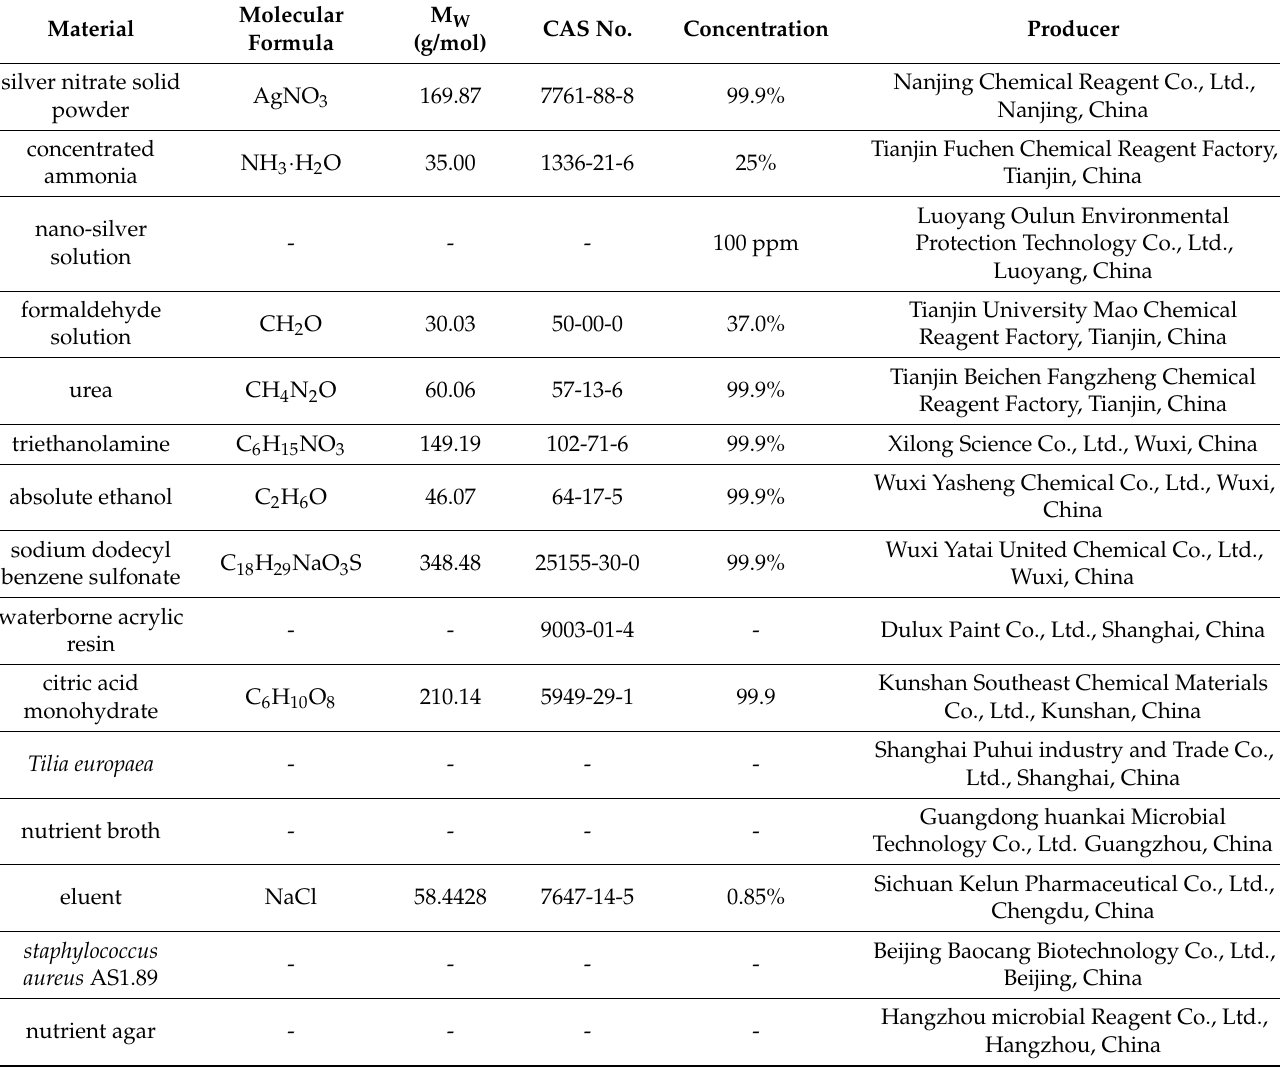
Table 1. List of experimental